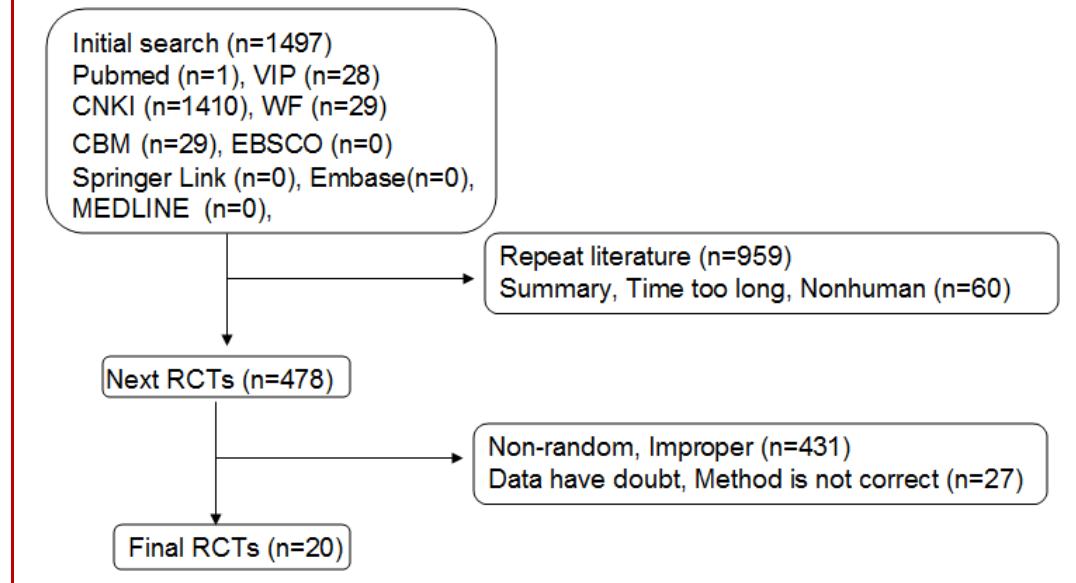
Figure 1: Flowchart of identification of studies included in the